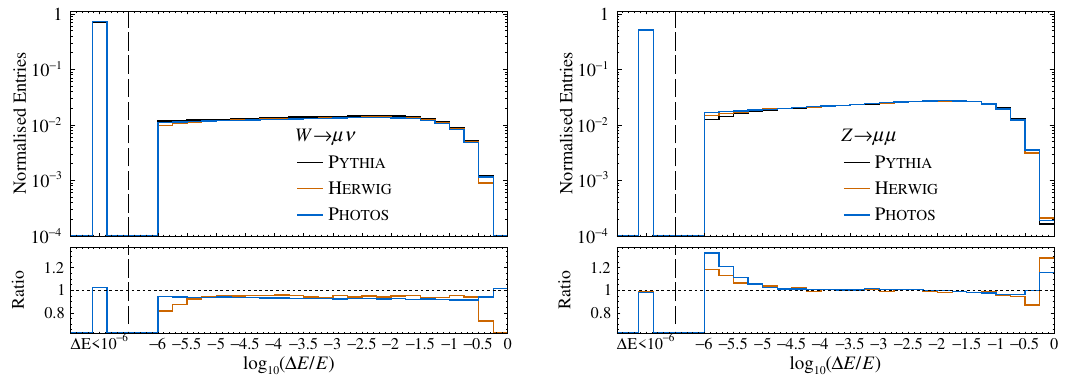
Figure 9 . Logarithm of the relative energy loss of the dilepton system due to final-state radiation for (left) W boson events and (right) Z boson events. An energy loss of below 10 − 6 is considered unresolvable and is accounted for in the underflow bin to the left of the dashed vertical line. In the lower panel the ratio with respect to Pythia is